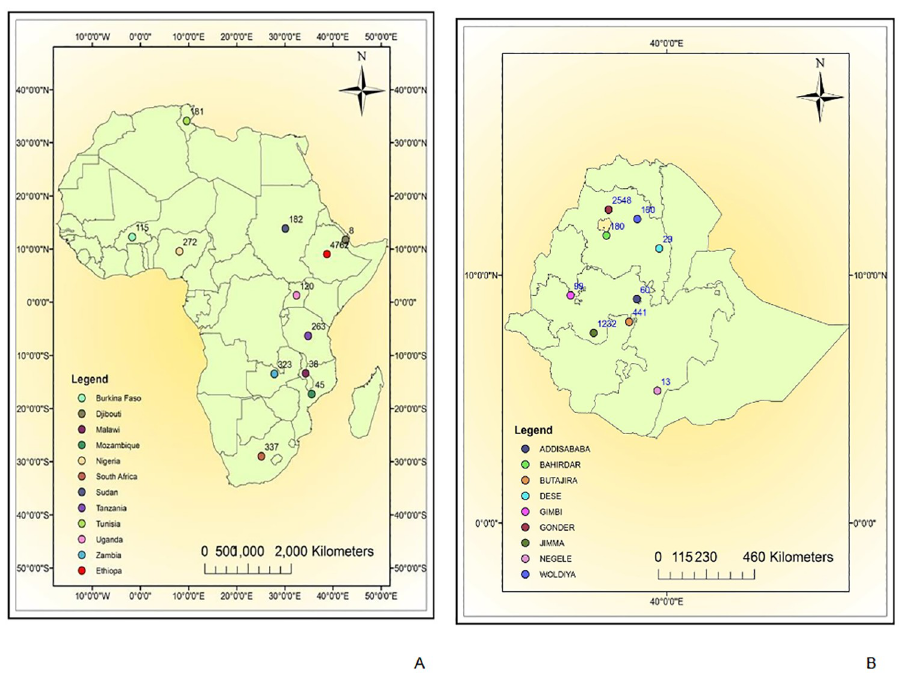
Fig 2. Geographic distribution and number of TBLN cases in Africa and Ethiopia, Africa,